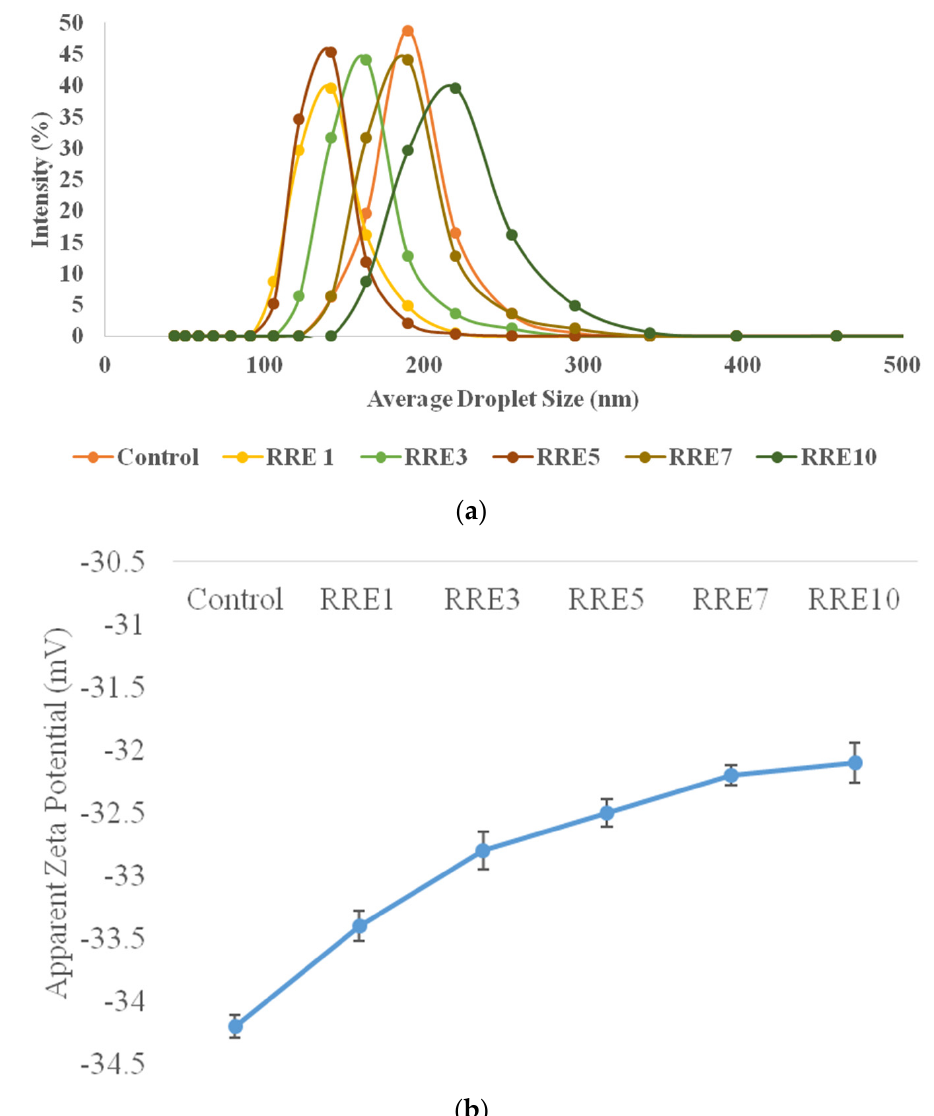
Figure 1. ( a ) Average droplet size, and ( b ) apparent zeta potential of control, RRE1, RRE3, RRE5, RRE7, and RRE10 nanoemulsion. Data are presented as means ± SD ( n = 3).